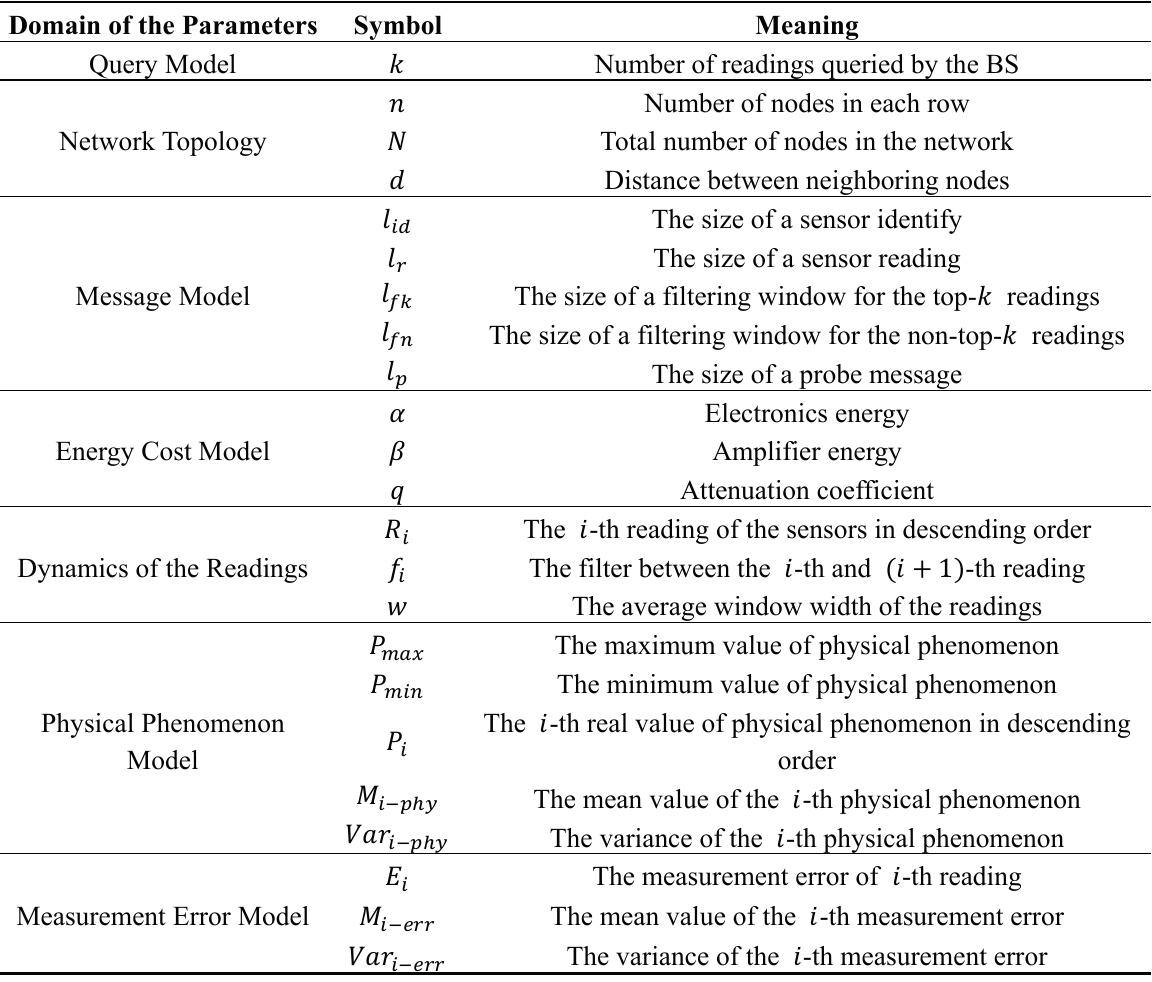
Table 2. Parameters and their